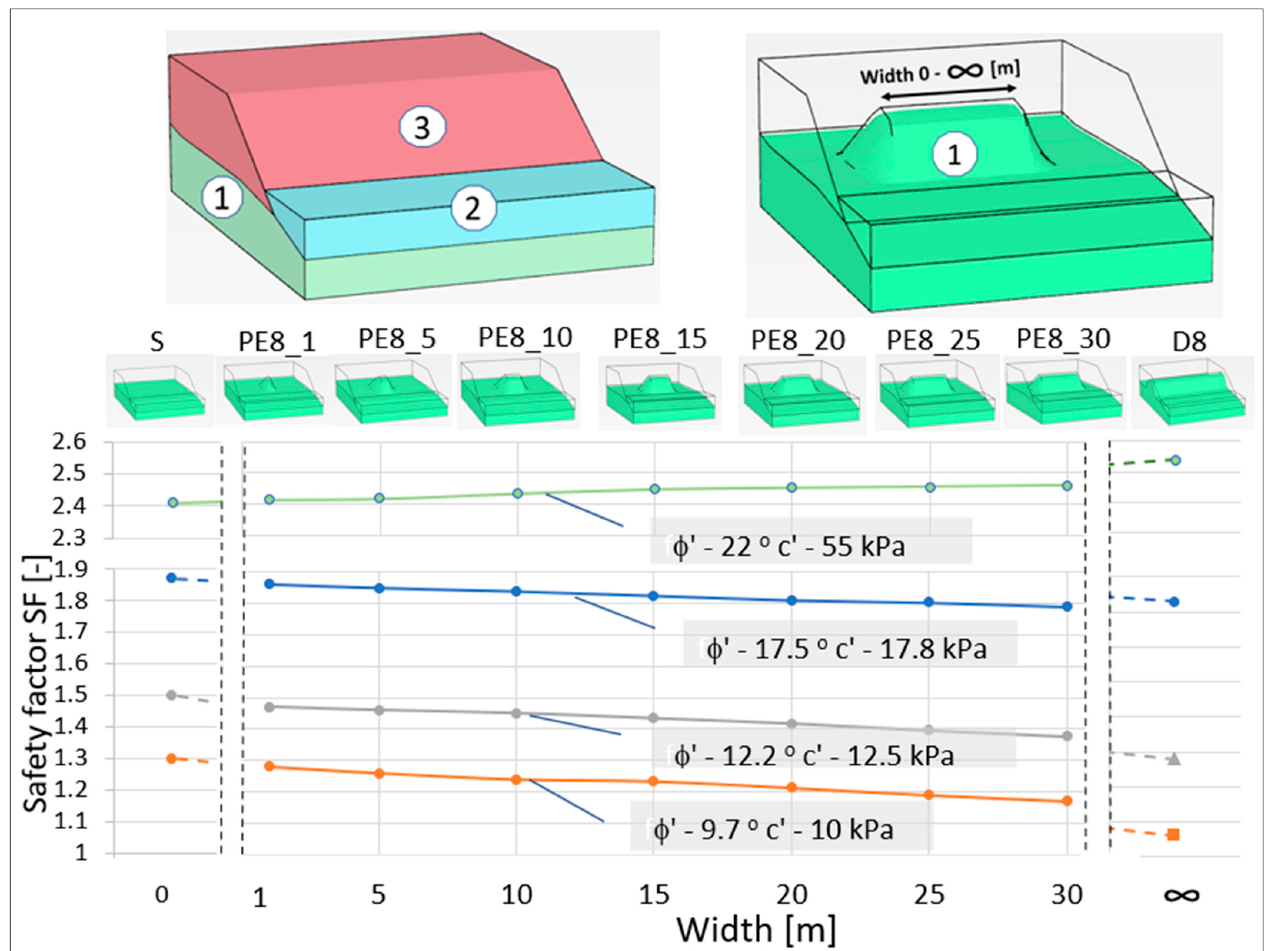
Figure 4. Results of slope stability 3D finite element modelling in different structural condition: (1) Cl/siCl—(clay, silty clay) strength parameters on above graph; (2) saCl/clSa—silty clay/clayey sand ϕ ’-22°; c’-44 kPa; (3) MSa—(medium sand) ϕ ’—30°; c’—0 kPa. Codification explanation: S—slightly inclined, PE—point elevation, D—dike-like form (type of disturbance with the height–disturbance width).